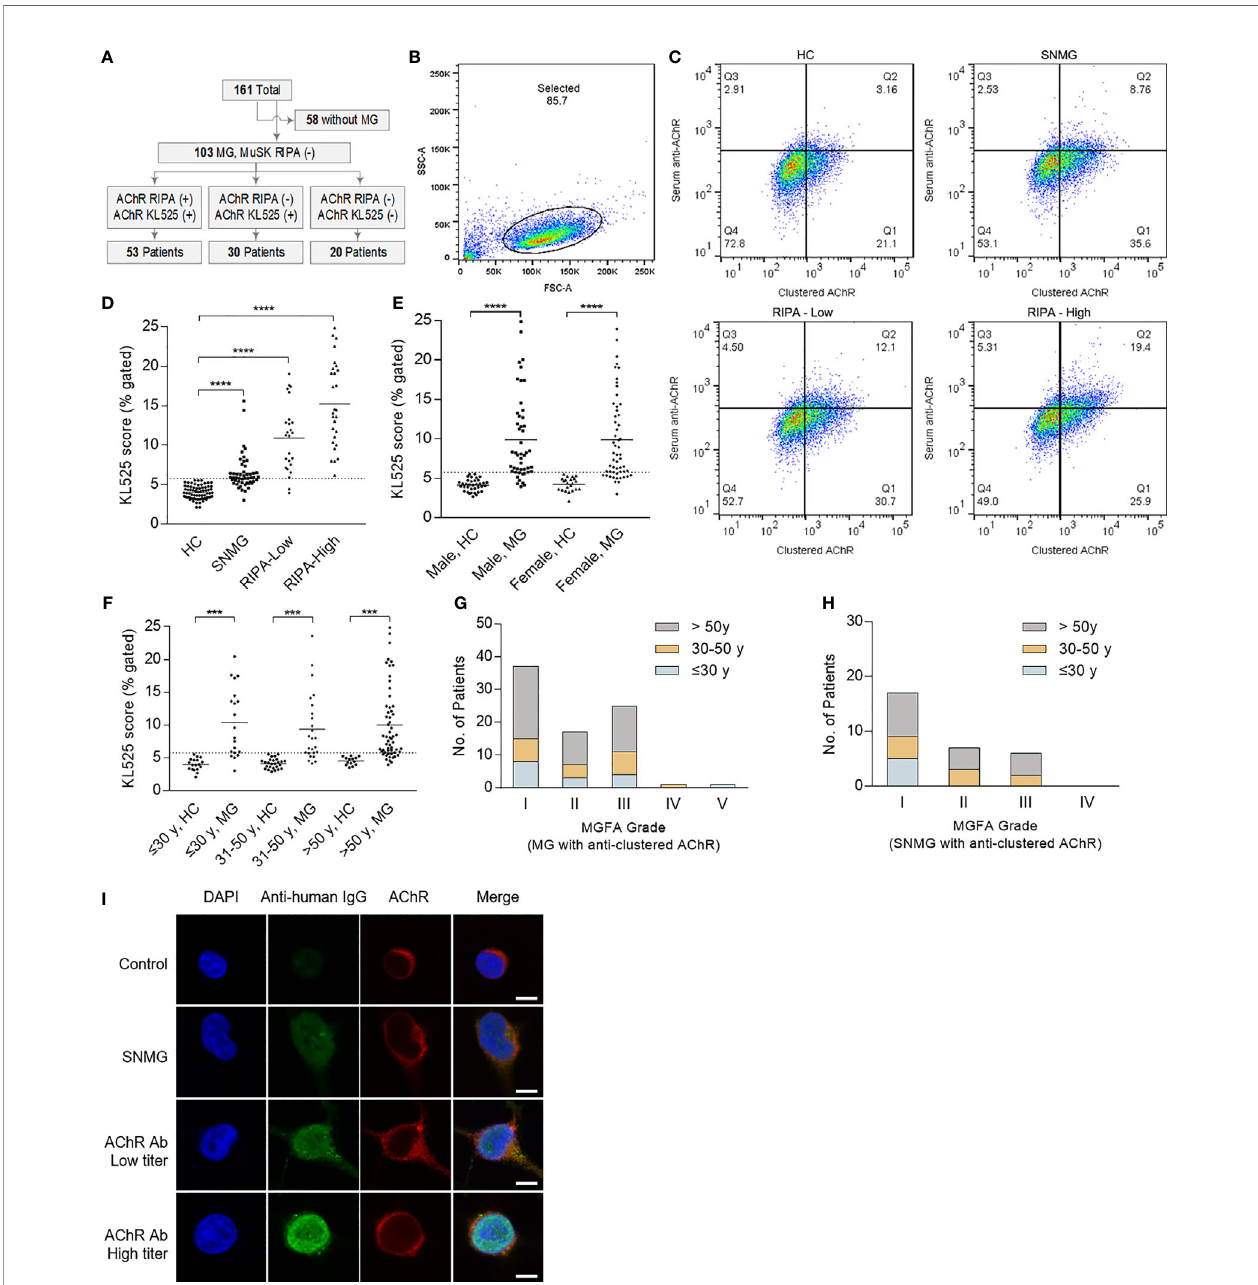
FIGURE 3 | Detection of AChR in patients with myasthenia gravis. (A) Flow diagram showing participants in this study. The cell line stably expressing the clustered acetylcholine receptor (AChR) (KL525) identi fi ed anti-AChR antibodies in 30 of 50 (60.0%) radioimmunoprecipitation assay (RIPA)-seronegative myasthenia gravis (SNMG) patients. MG indicates myasthenia gravis, and MuSK indicates muscle-speci fi c tyrosine kinase. (B – D) Representative results of FACS results and analysis of the KL525 score (double-positive cells for both AChR expression and serum antibody binding). The threshold KL525 score was 5.78, determined according to the mean + 2 SDs of the results from the negative controls. KL525 scores in healthy control group (HC, n = 58), in patients with positive for anti-AChR antibodies with a high RIPA titer (RIPA-High, RIPA ≥ 8 nmol/L, n = 28), in patients with positive for anti-AChR antibodies with a low RIPA titer (RIPA-Low, 0.5 nmol/L<RIPA<8 nmol/L, n = 25) and in patients with SNMG (n = 50). (E) KL525 scores in male healthy control (HC) group, male MG patients, female healthy control group and female MG patients. (F) KL525 scores in healthy individuals less than or equal to 30 years old, MG patients less than or equal to 30 years old, healthy individuals in 30-50 age range, MG patients in 30-50 age range, healthy individuals older than 50 years old, MG patients older than 50 years old. (G) MGFA grade in MG patients with clustered anti-AChR antibody detected by KL525. (H) MGFA grade in SNMG patients with clustered anti-AChR antibody detected by KL525. (I) Representative immuno fl uorescence staining. Triple immuno fl uorescence staining with DAPI (blue), anti-human antibody (Anti-human, green) and anti-mouse antibody (Anti-mouse, red) in KL525 cells exposed to human serum. Anti-human secondary antibody was used to detect anti-AChR antibody in human serum, and anti-mouse antibody was used to detect mouse AChR d antibody bound to clustered AChR expressed in KL525 cells. Bar, 10 m m. ***P < 0.001, ****P <